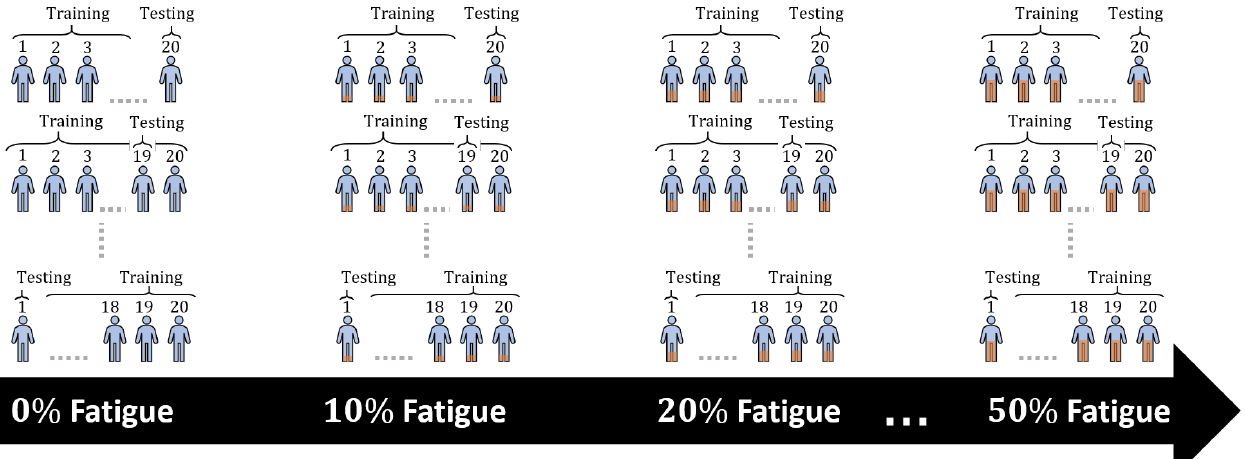
Figure 10. A partial representation of the six Leave-One-Out Cross-Validations (LOOCV) with K = 20 and different percentages of